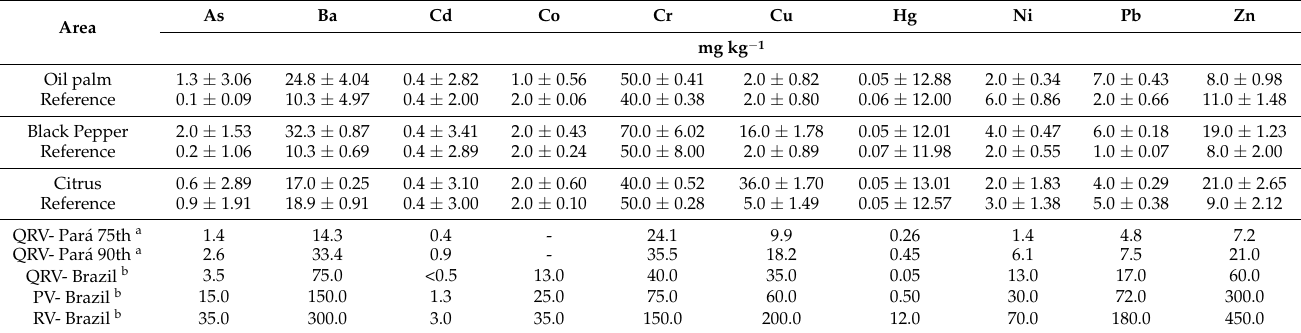
Table 2. Concentrations of potentially toxic elements in soils and quality guidelines.